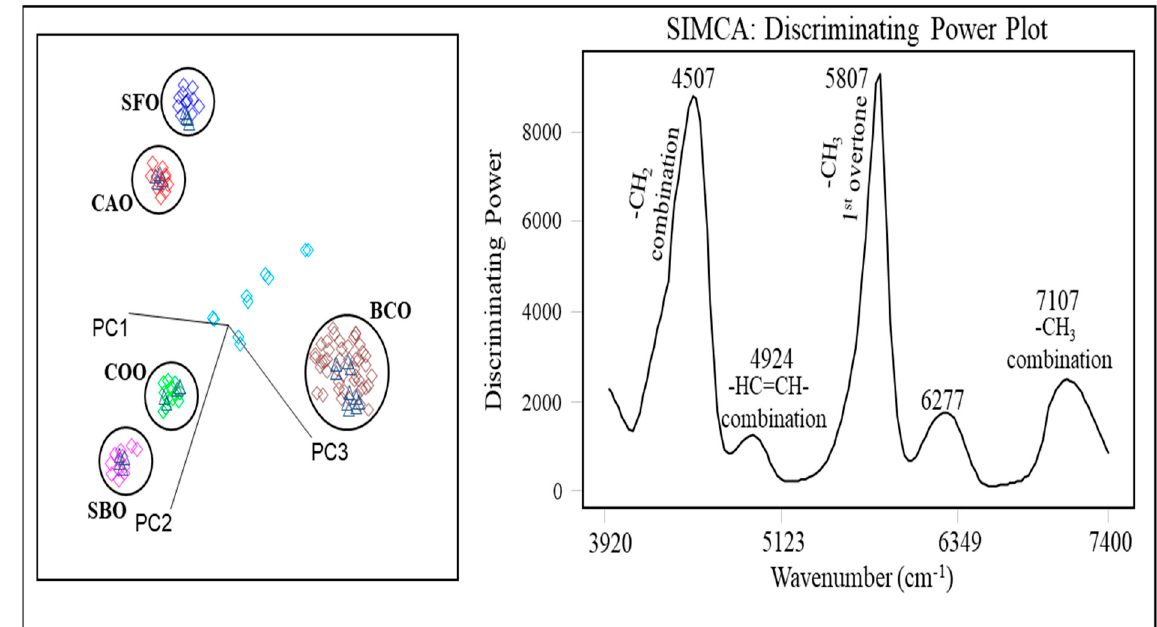
Figure 1. Soft independent modeling of class analogy—3D projection and discriminating power by SIMCA obtained from handheld FT-NIR. BCO: black cumin oil; CAO: canola oil; COO: corn oil; SBO: soybean oil; SFO: sunflower oil; triangles: validation; unclassified: adulterated black cumin oils; PC1-2-3: Principal Component.